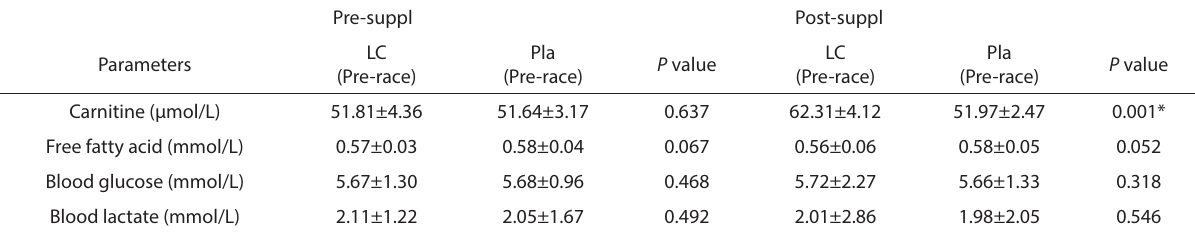
Table 3. Physiological parameters before start of the race between groups before and after supplementation period